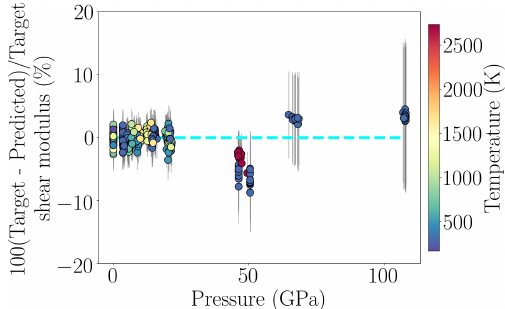
Figure 2. Prediction performance of the trained MDN as a func- tion of pressure using the test set. The mean of the posterior pdf’s on the shear modulus predicted by the MDN is subtracted from the actual shear modulus values of the test set (i.e. target values) to compute the variation in the shear modulus. The mean variation is shown as circles, and the size of uncertainty (1 standard deviation) is given by grey error bars. One could also represent the same in- formation by using the log-likelihood function given by the MDN instead. The dashed cyan line refers to a perfectly resolved shear modulus. Hence, the closer the data plot to the line, the better the resolving power of the neural network. The differences between tar- get and predicted shear modulus values are mostly located close to the cyan line, although intermediate- and high-pressure predictions are more uncertain and are located away from it. The range of tem- perature of the test data is given by the colour bar on the right. Note some error bars are smaller than or comparable to the plotting sym-